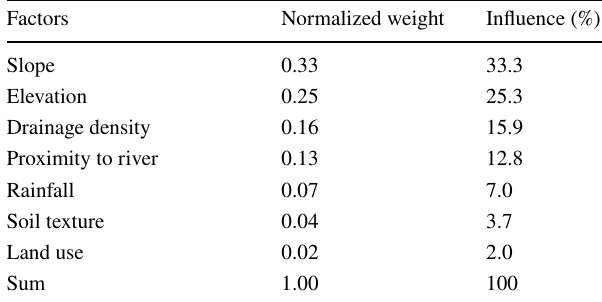
Table 6 The Eigen vector weights of each flood factors obtained